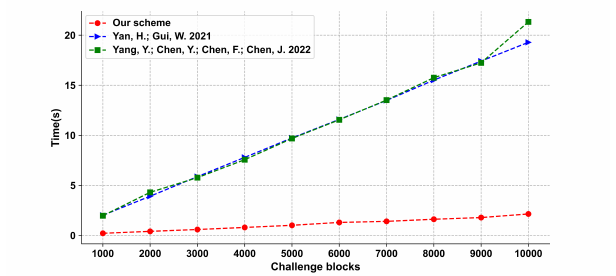
Figure 3. Computation cost of TagGen [21,38].